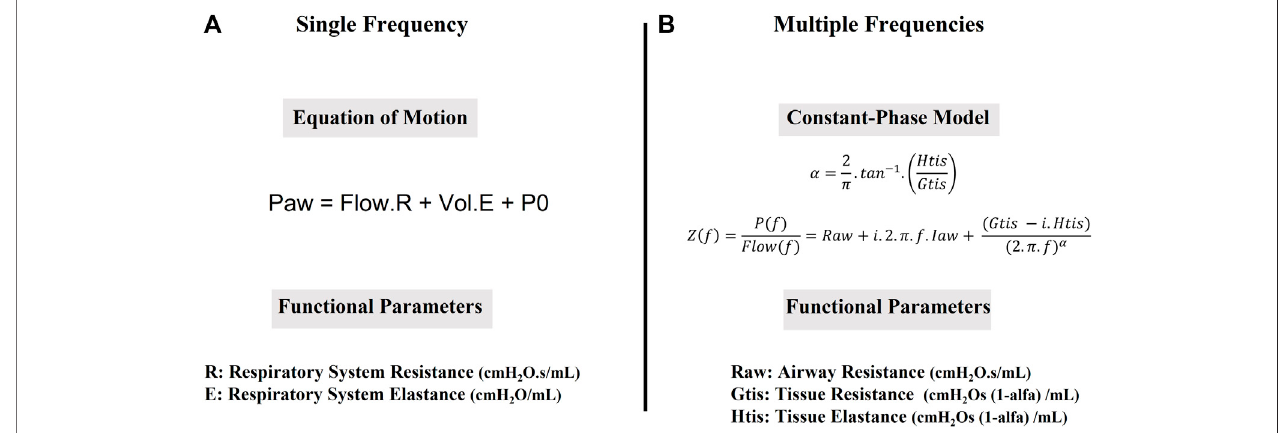
FIGURE1| Mathematicalmodelsusedtoobtainfunctionalparameters. (A) .TheequationofMotion:Paw(cmH 2 O)isairwaypressure,measuredatairwayopening, Flow(mL/s)isairway fl ow,RisRespiratorySystemResistance(cmH 2 O.s/mL),Vol(mL)istheVolumeofairthathasenteredthelungssincethebeginningofinspiration,E (cmH 2 O/mL) is Respiratory System Elastance and P0 (cmH 2 O) is the airway pressure at the beginning ofinspiration. (B) . The Constant PhaseModel (Z(f), cmH 2 O.s/mL)